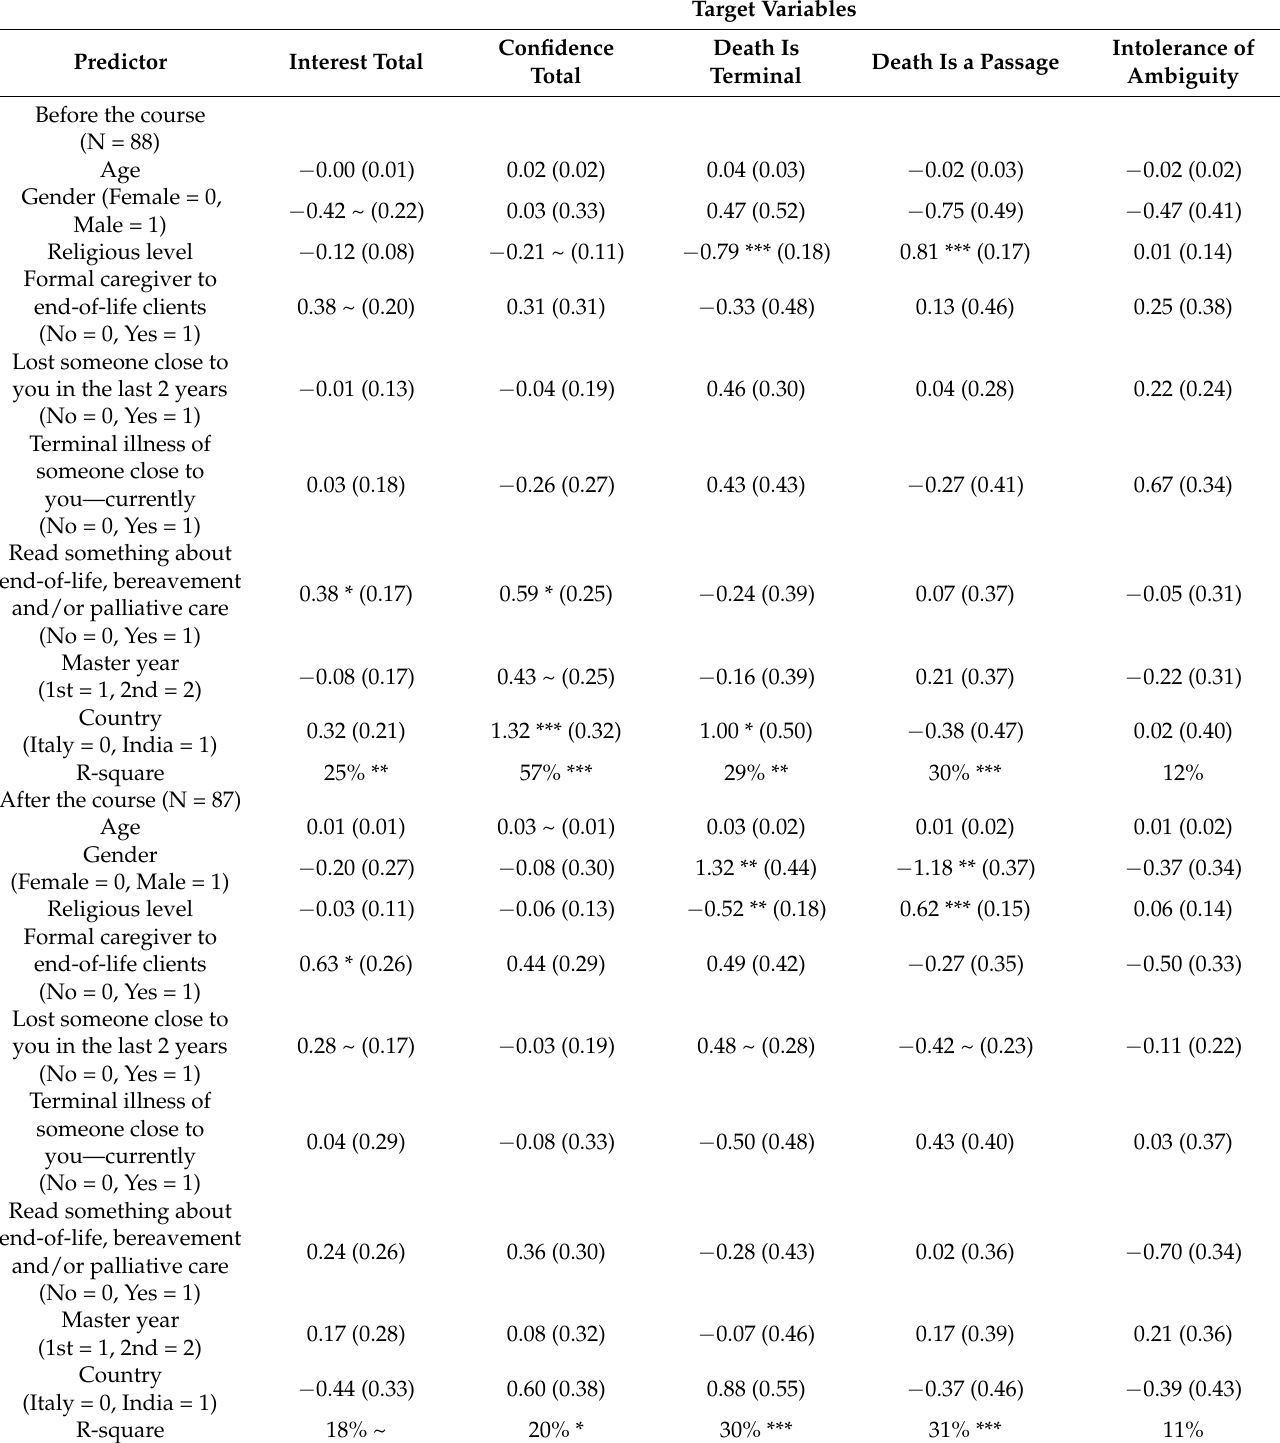
Table 2. Regression analysis on target variables before and after the course. Target